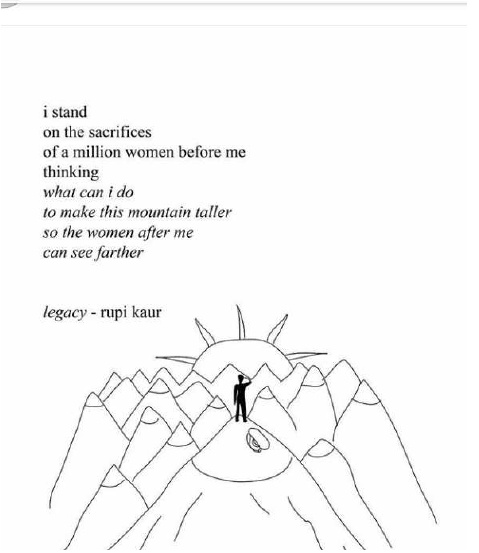
Figure 2. Screenshot of Kaur’s poetry: